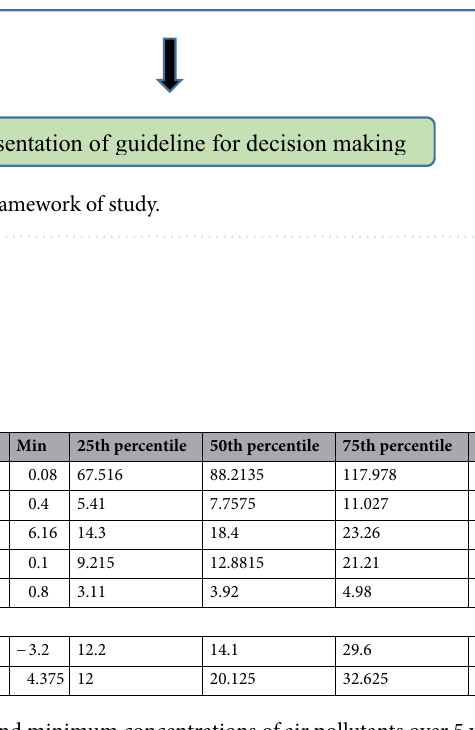
Table 1. Mean, maximum and minimum concentrations of air pollutants over 5